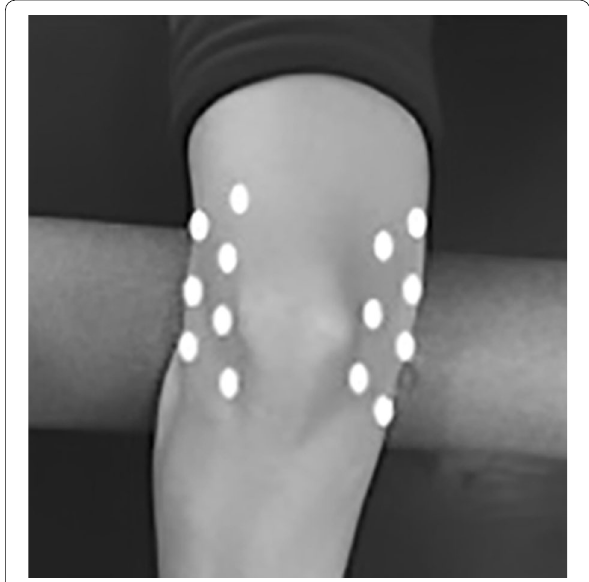
Fig. 1 PBMT irradiation